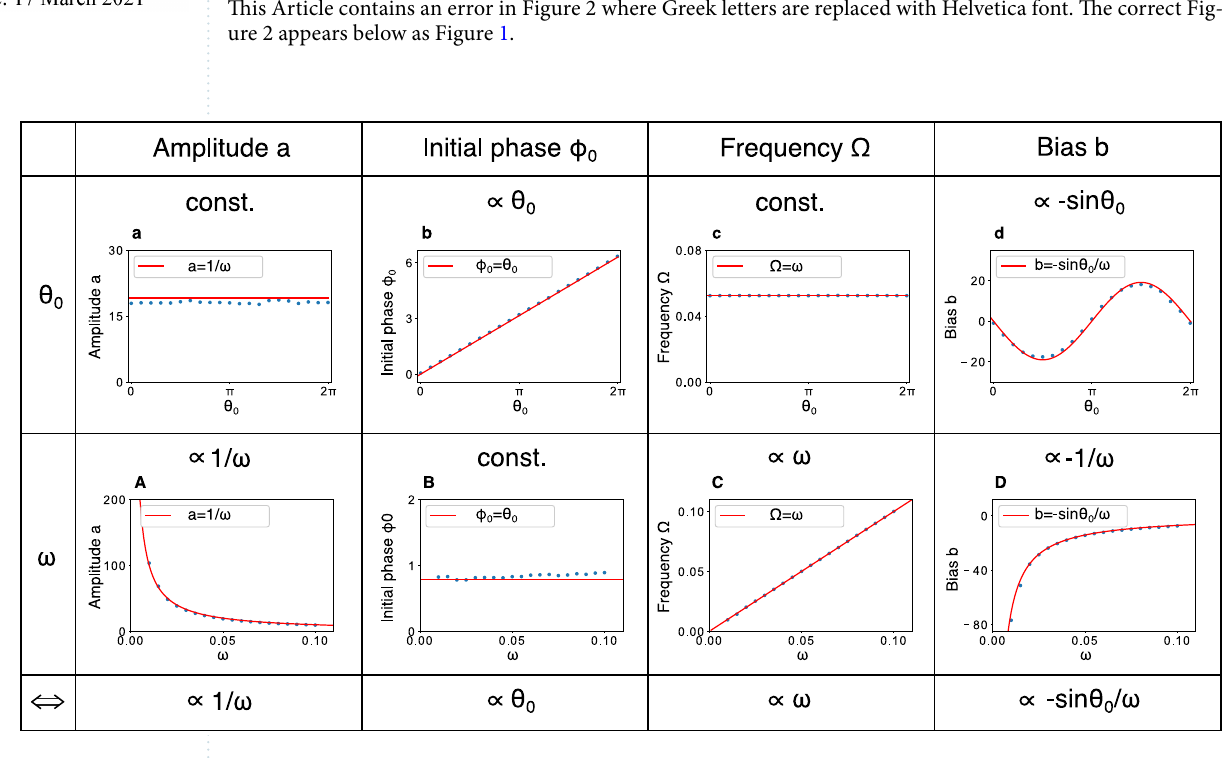
Figure 1. A correct version of the original Figure